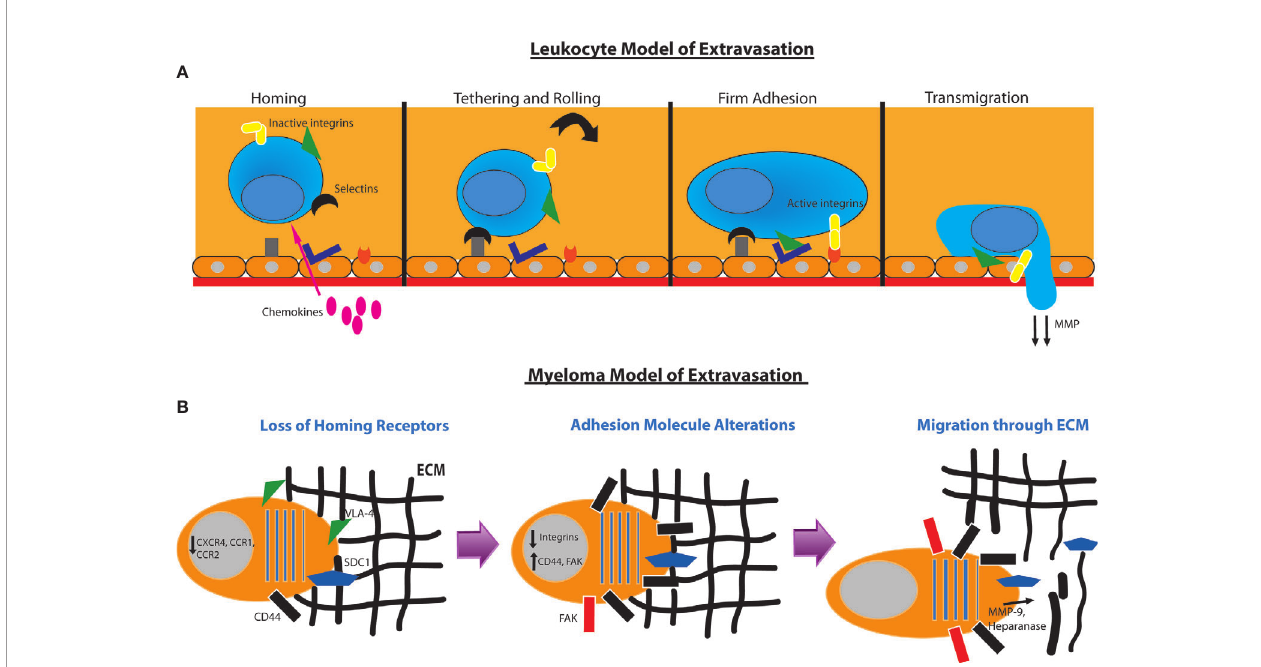
FIGURE 2 | Models for leukocyte and myeloma cell extravasation. (A) Standard leukocyte multistep model of extravasation . The leukocyte in the bloodstream receives homing signals from chemokines. This is followed by weak adhesion to the endothelium and rolling along the surface. Integrins such as VLA4 and LFA1 are activated to form tight adhesion to the endothelium. The leukocyte then reorganizes its cytoskeleton and degrades the basement membrane to transmigrate through. (B) Model of myeloma extravasation out of the bone marrow. Myeloma cells downregulate receptors used for homing to the bone marrow. They alter adhesion molecules by downregulating integrins and increasing hyaluronan receptors such as CD44 and RHAMM and expression of focal adhesion kinase (FAK). The myeloma cell will secrete MMP-9 and heparanase as well as induce production of MMP-9 via endothelial cells to degrade the extracellular matrix (ECM). Heparanase secretion can cause shedding of SDC1 which also contributes to cell motility. The myeloma cell will then reorganize its cytoskeleton and migrate through the